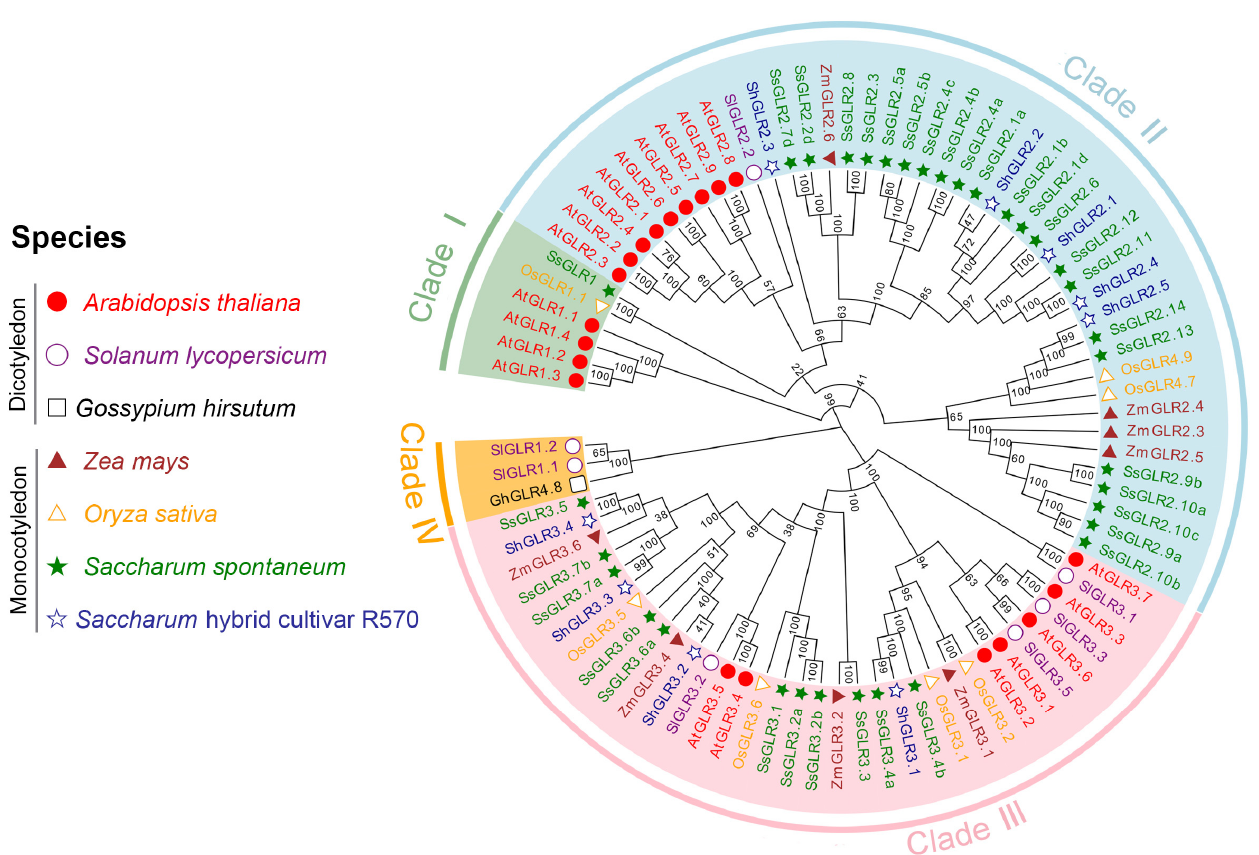
Figure 1. Phylogenetic relationship of GLR proteins in different plant species. The MEGA-X (64 bit) ClustalW with the parameters of gap-opening penalty = 10 and gap-extension penalty = 1 and using the Neighbor-Joining (NJ) method (p-distance model, 1000 ultrafast bootstraps) to conduct the original phylogenetic tree. The number on the branch represented the bootstrap value. All the GLR protein sequences are listed in Table S5.